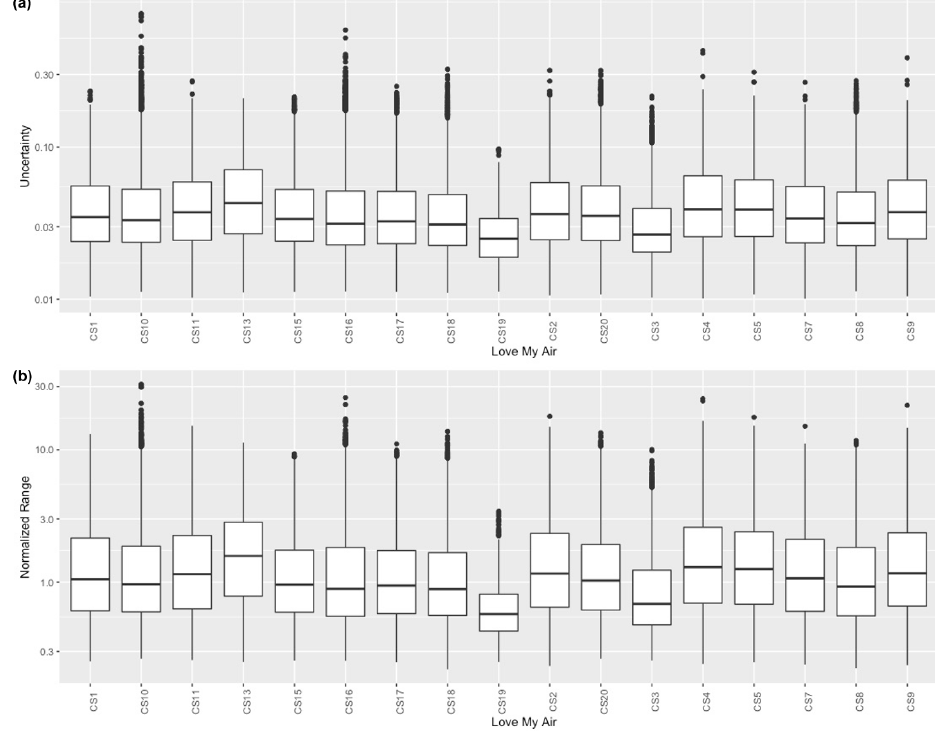
Figure 7. Distribution of (a) uncertainty and (b) normalized range (NR) in hourly calibrated measurements across all 89 calibration models at each site using the methodology described in Sect. 2.3.5.